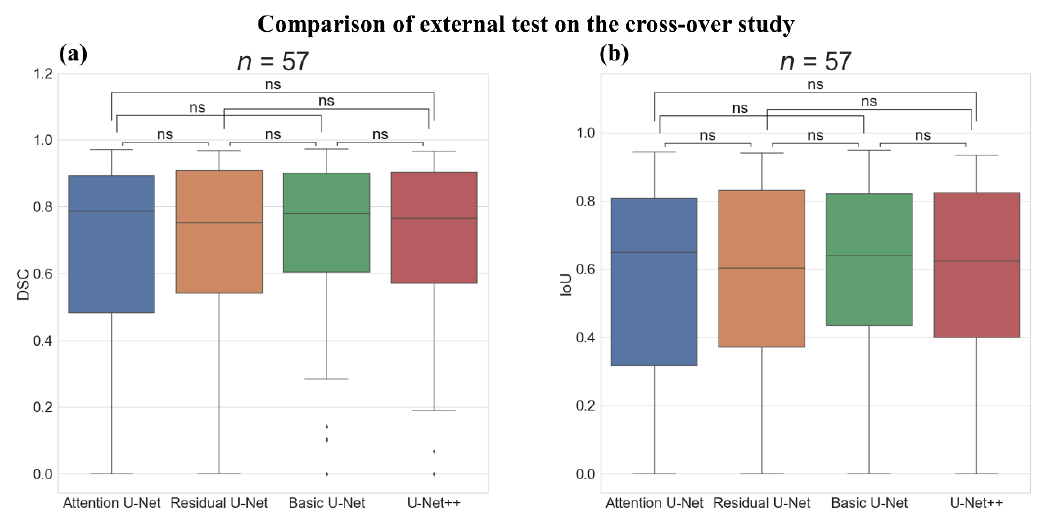
Figure 9. Comparison of the external test on the cross-over study with Boxplot representation and Wilcoxon test results between the deep-learning algorithms. ( a ) Boxplot representation and Wilcoxon test results of dice similarity score (DSC) and ( b ) Boxplot representation, and Wilcoxon test results of intersection over union score (IoU). ns: not significant, Number of images ( n ) = 57.